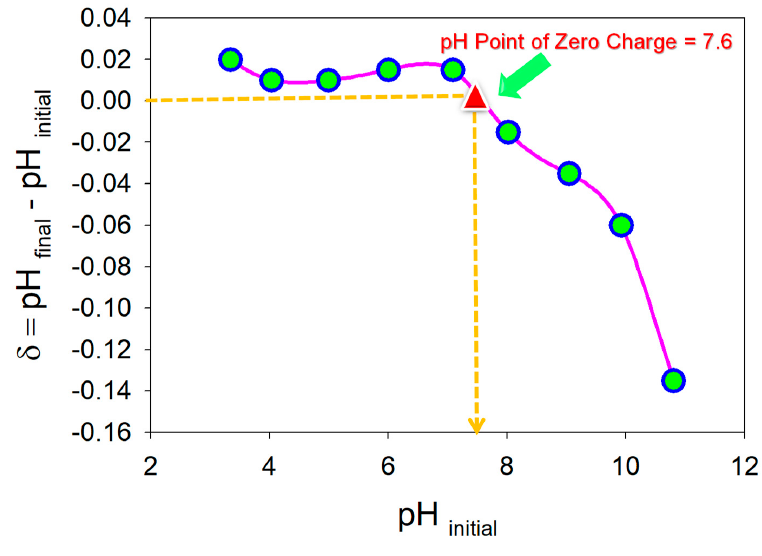
Figure 6. Point of zero charge plot (pH PZC ) of Aphanothece sp. (W 0 = 0.1 g / L, C 0 = 1 mg / L, t contacts = 60 min, T = 30 ◦